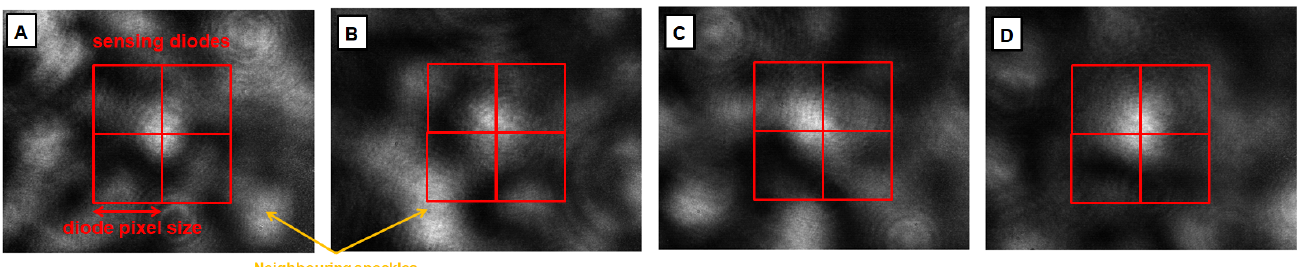
Figure 7. Speckle images ( A – D ) that are evaluated for their single speckle sensing capability. The diode sensing regions are indicated by the red